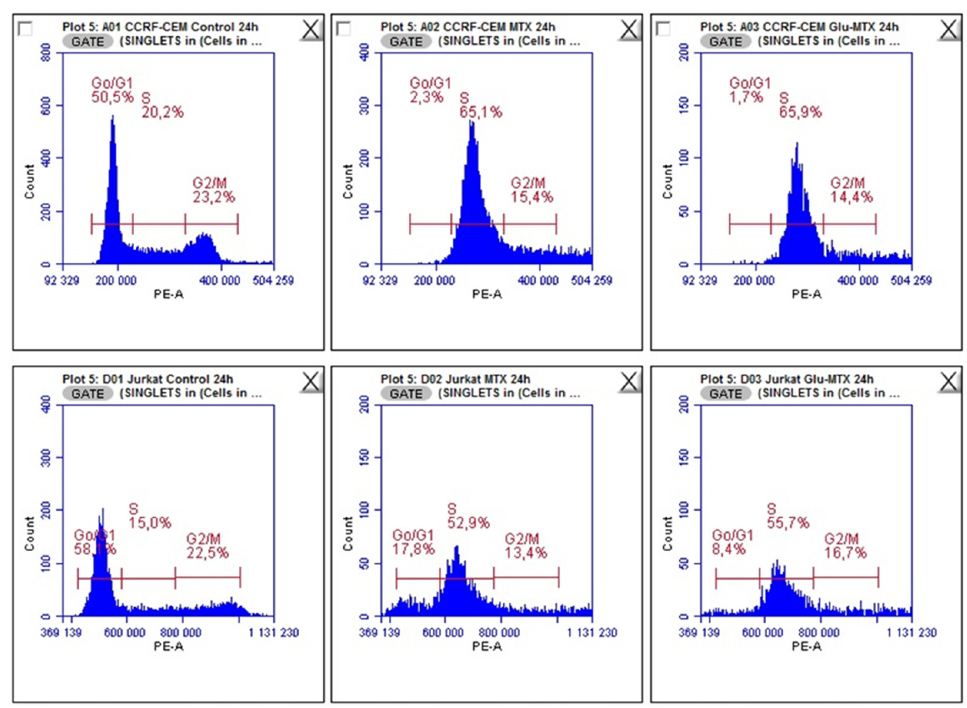
Figure 6. Cell cycle analysis of CCRF–CEM and Jurkat cells after treatment with 0.1 µM MTX and Glu–MTX for 24 h. For leukemia cells, cell cycle arrest in the S phase is characterized by the action of both the Glu–MTX conjugate and free methotrexate.